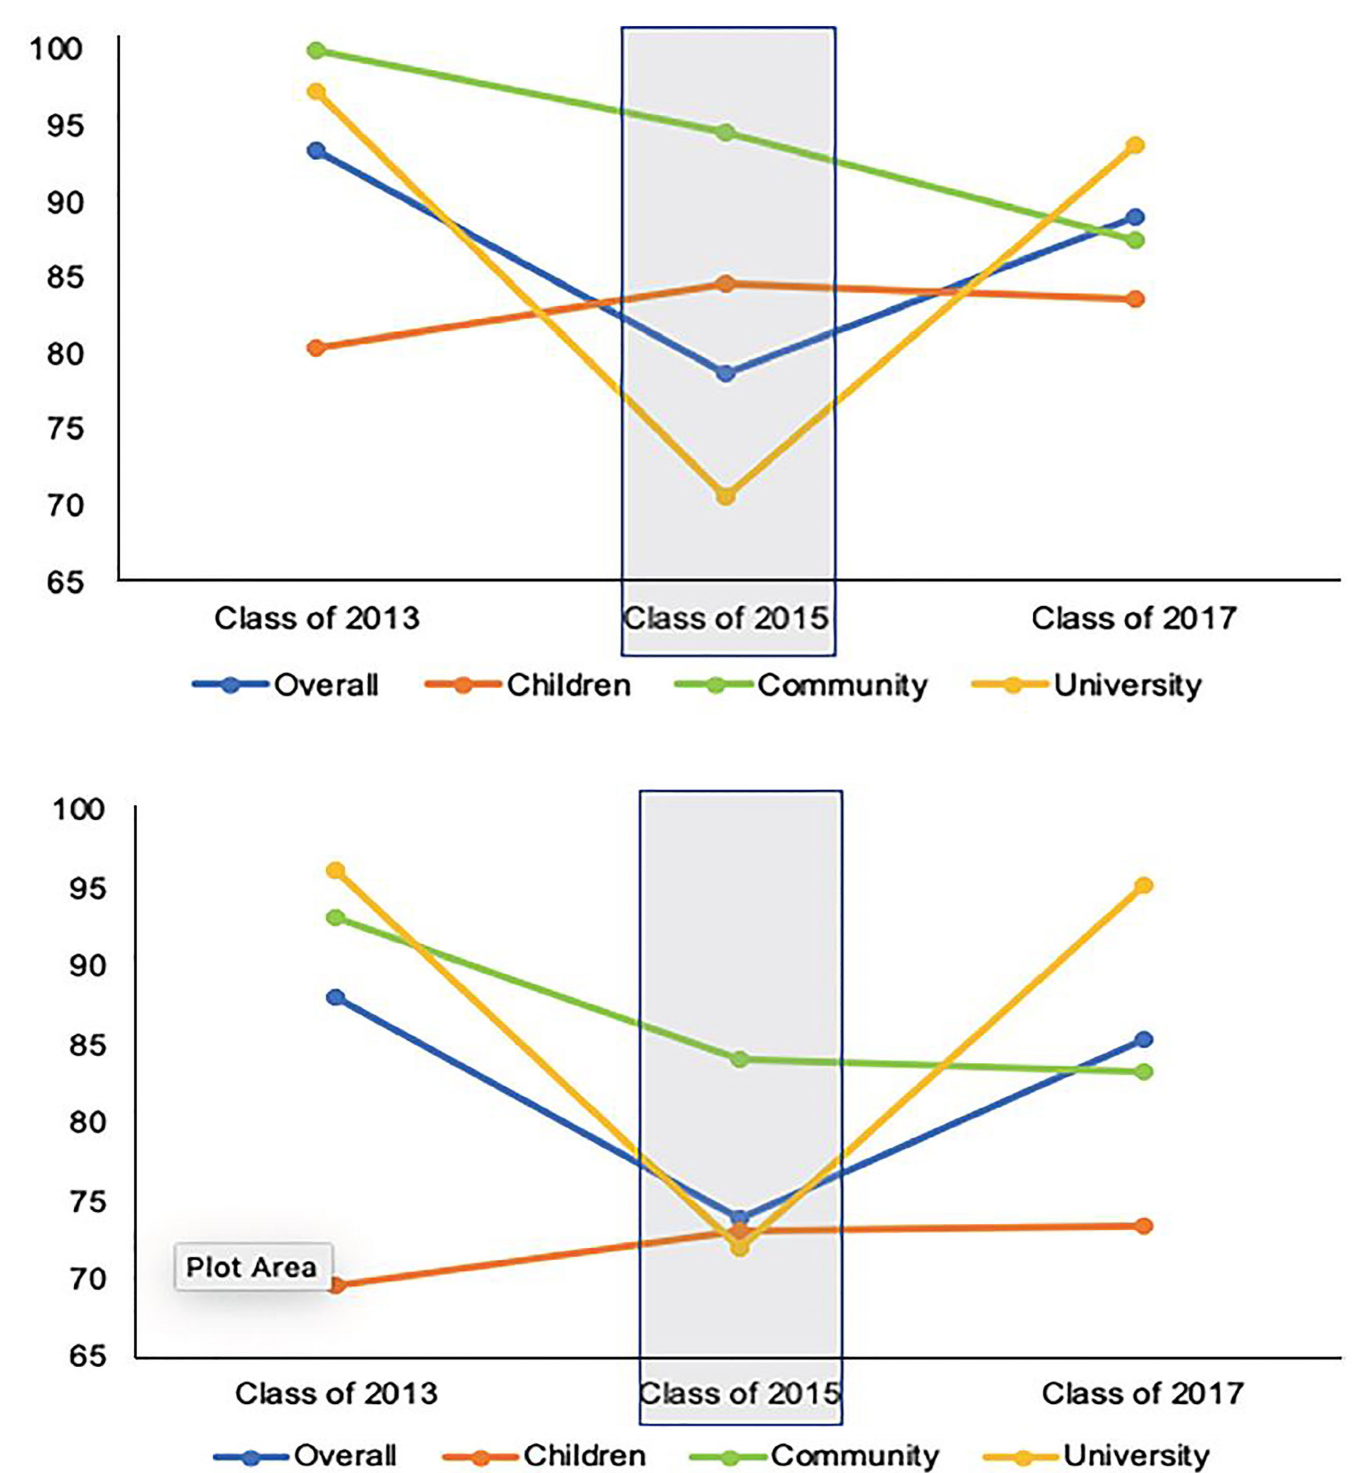
Figure 2. Top-box proportions of ratings for the classes of 2013, 2015, and 2017 for each clinical site and overall for quality of clinical teaching and overall clerkship